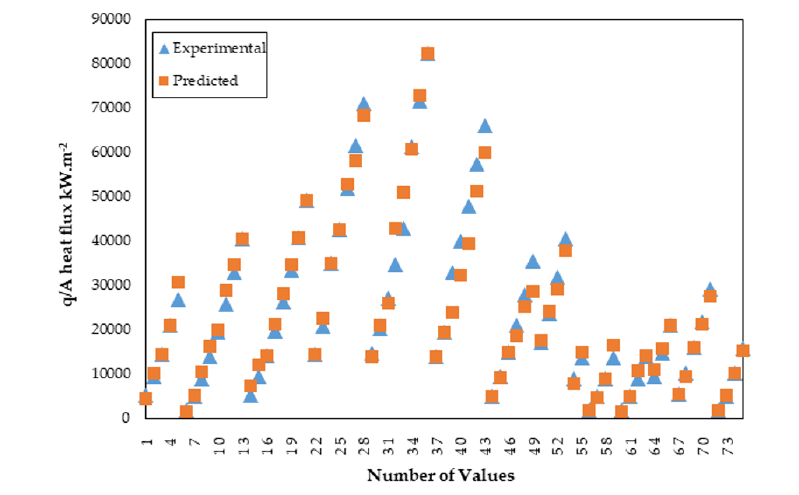
Figure 7. The SVMReg